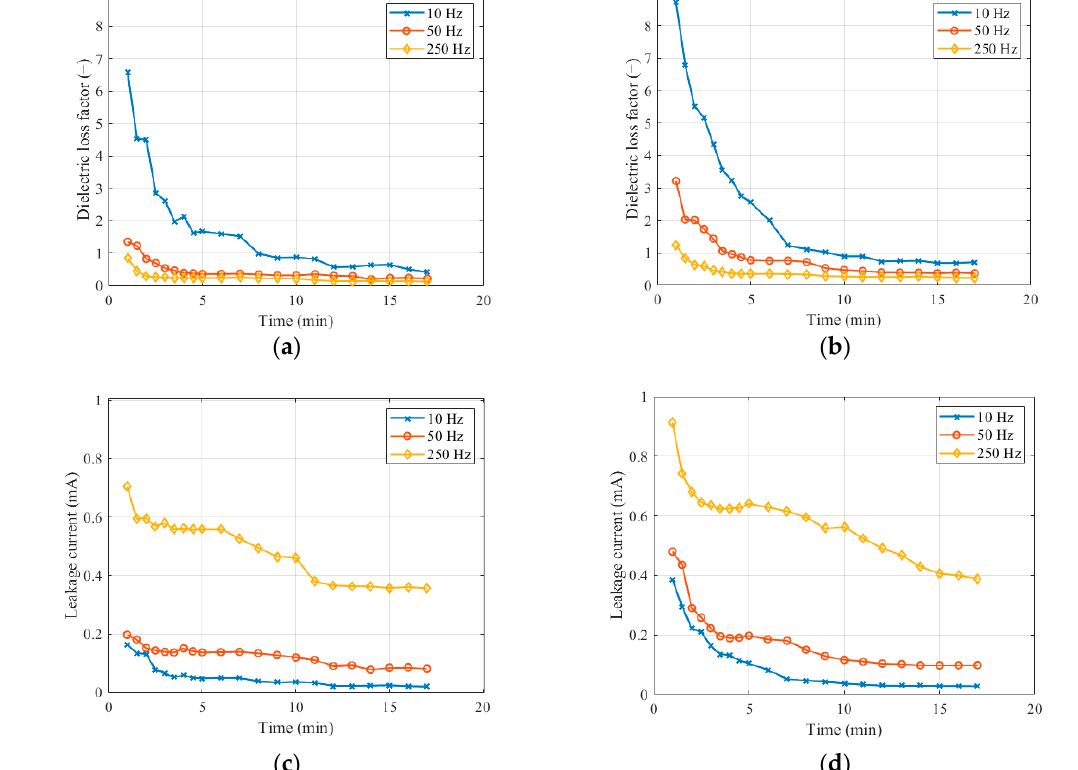
Figure 5. Change in quantities: ( a ) dielectric loss factor (L1); ( b ) dielectric loss factor (L2); ( c ) leakage current (L1); ( d ) leakage current (L2).